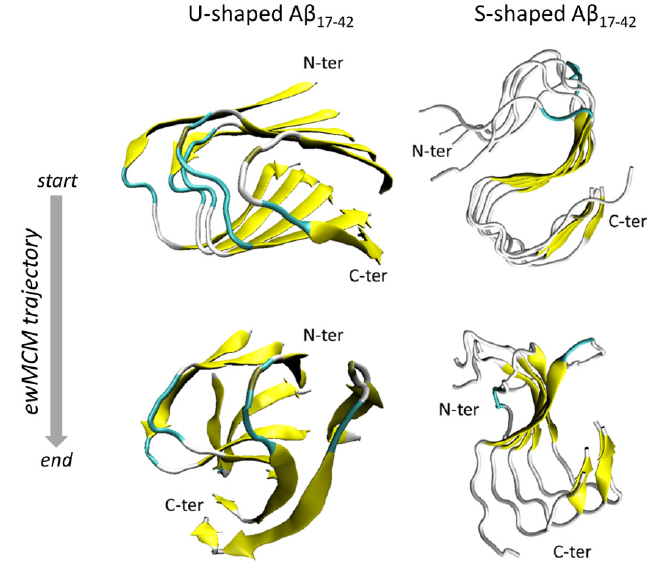
Figure 5. Snapshots representing the starting and the final configuration extracted from the ensemble weighted Maximally Correlated Motion (ewMCM) for U-shaped and S-shaped models after performing the Functional Mode Analysis (FMA) on the REMD ensemble at 300 K.